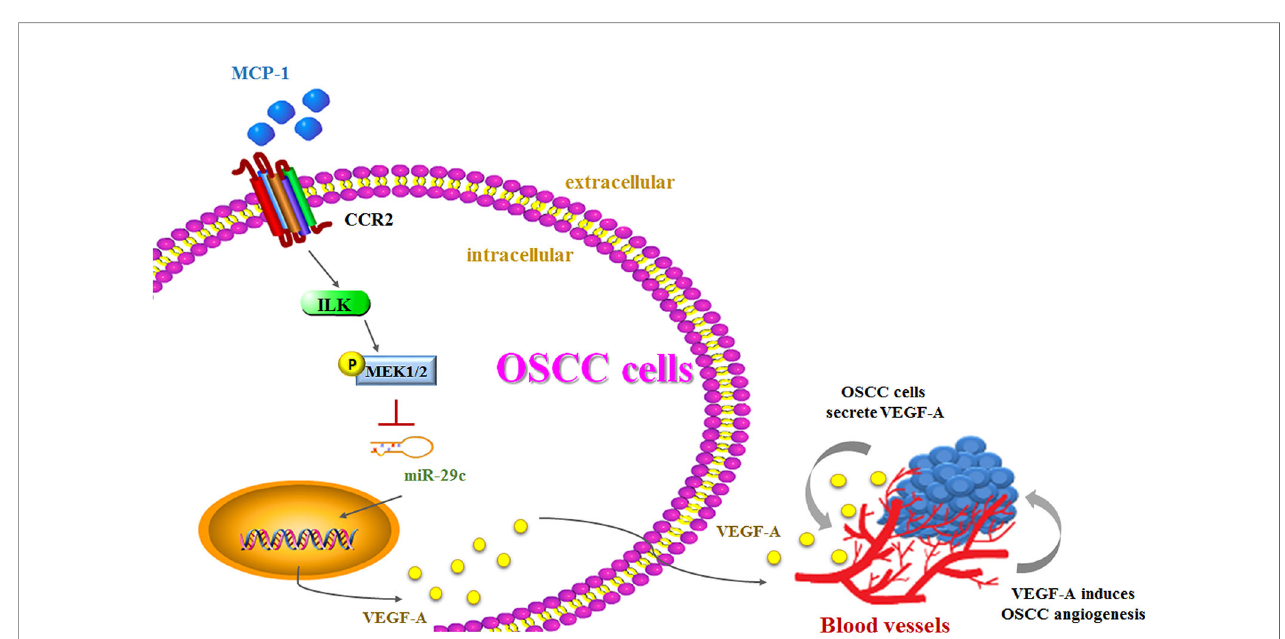
FIGURE 7 | The schema depicts the involvement of signaling pathways in MCP-1 – induced stimulation of VEGF-A expression and